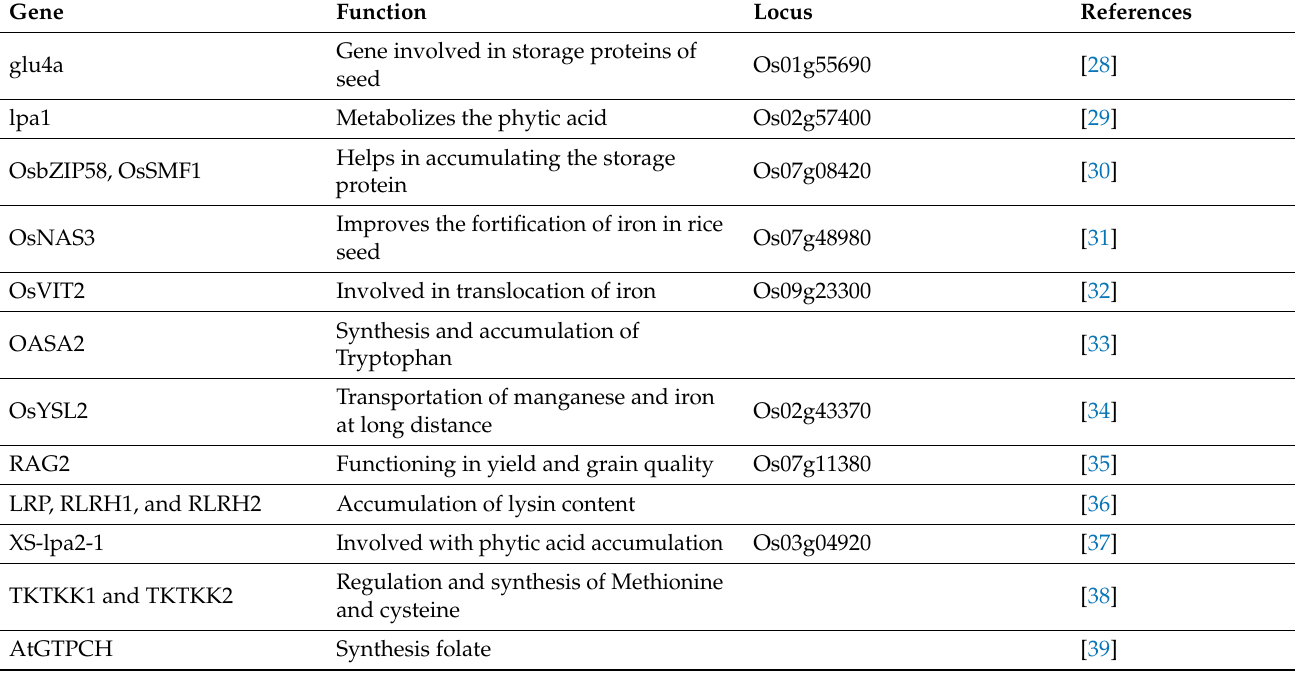
Table 1. Some rice genes that control regulation of nutritional quality